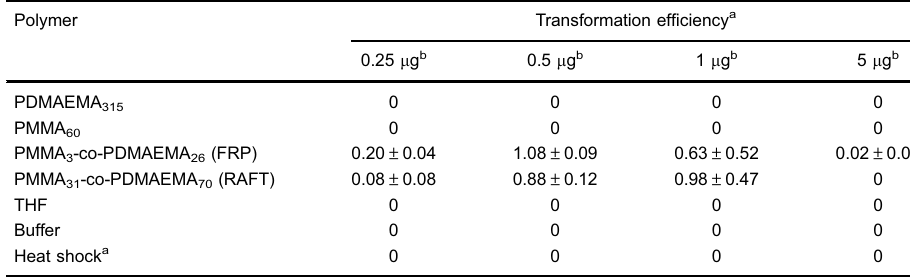
Figure 5. Demonstration of pUC19 transfection by polymers. Expression of pUC19 in E. coli DH5 a using the blue-white screening test. A , PMMA 3 -co-PDMAEMA 26 (FRP). B , PMMA 31 - co-PDMAEMA 70 . The amount of copolymer used in these experiments was 0.5 m g (left plates) and 1 m g (middle plates). The plates on the right refer to the inoculation of a single bluish colony, from the plates incubated with 1 m g of polymer, in new agar plates containing IPTG and X-Gal. FRP: free radical Table 2. Escherichia coli transformation ef fi ciency (10 3 CFU/ m g of DNA).